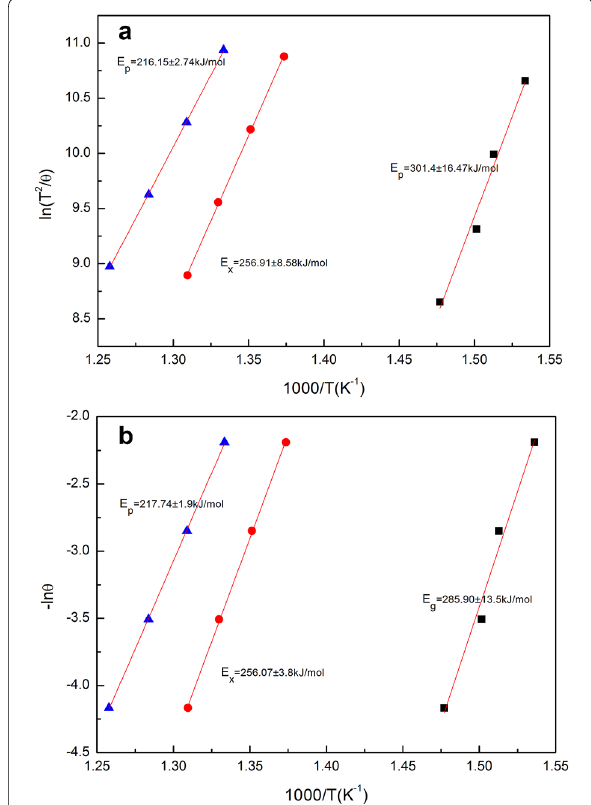
Figure 4 Determined activation energies ( E g , E x , E p ) by Kissinger and Ozawa methods of Zr